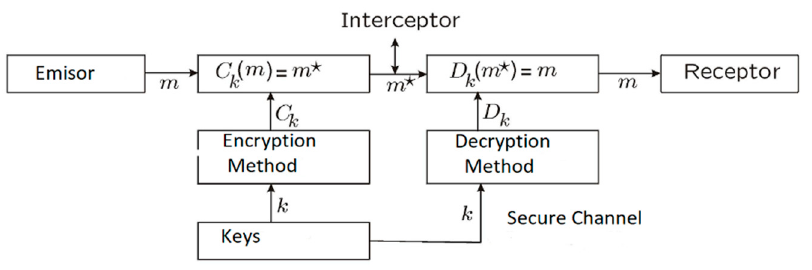
Figure 2. Cryptographic system. Where m denotes the message to be transmitted and m* the encrypted message.